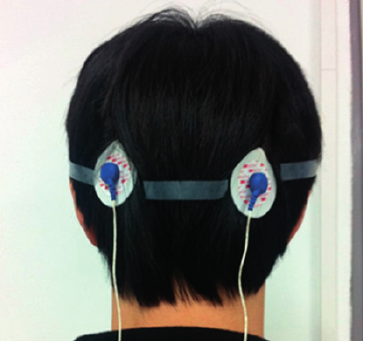
Figure 22. EEG signal measurement environment.